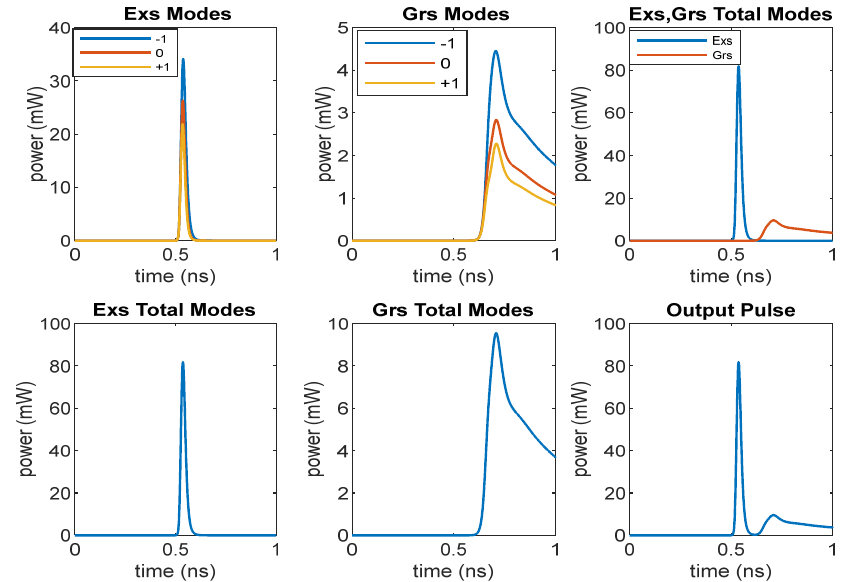
Figure 12. Output pulse under the illumination of an EOGB of 10 mW for I rf = 12 mA.